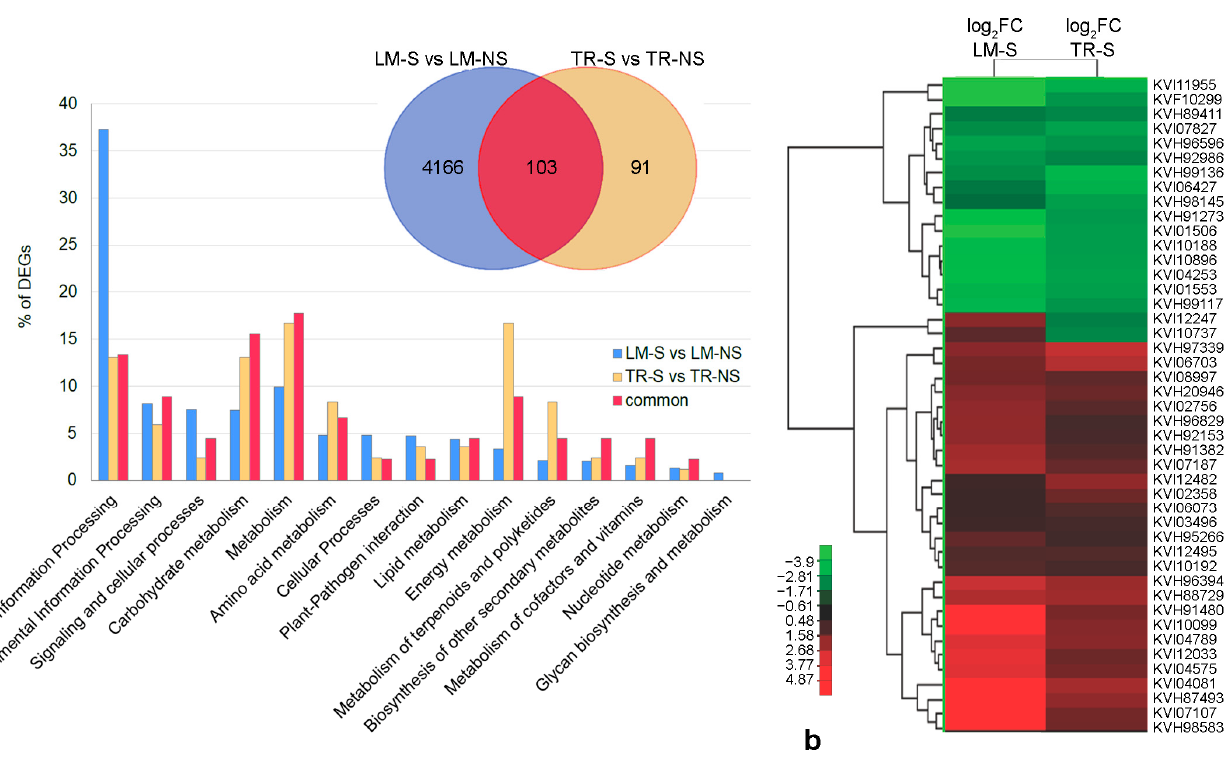
Figure 3. Functional classification and hierarchical clustering analysis of differentially expressed genes (DEGs) in sanitized (S) vs. non-sanitized (NS) samples of Locale di Mola (LM) and Troianella (TR). ( a ) The Venn diagram shows the number of DEGs (|log 2 FC| ≥ 1; FDR ≤ 0.05) in S vs. NS sam- ples of LM and TR. The histogram shows the functional distribution of annotated DEGs exclusively modulated in response to the sanitation protocol (S vs. NS) in LM (4166 DEGs, blue bars), in TR (91 DEGs, yellow bars), and in common (103 DEGs, red bars) between LM-S and TR-S compared to NS samples. ( b ) The heatmap shows a hierarchical clustering analysis of expression levels (log 2 FC) of annotated DEGs (45 out of 103 genes) in common between LM-S and TR-S compared to NS samples. In detail, gene transcripts KVI08997 (ca ff eoyl-CoA O -methyltransferase, CCoAMT ), KVI06073 (cinnamoyl-CoA reductase 1, CCR1 ), and KVI04575 (ca ff eic acid 3- O -methyl-